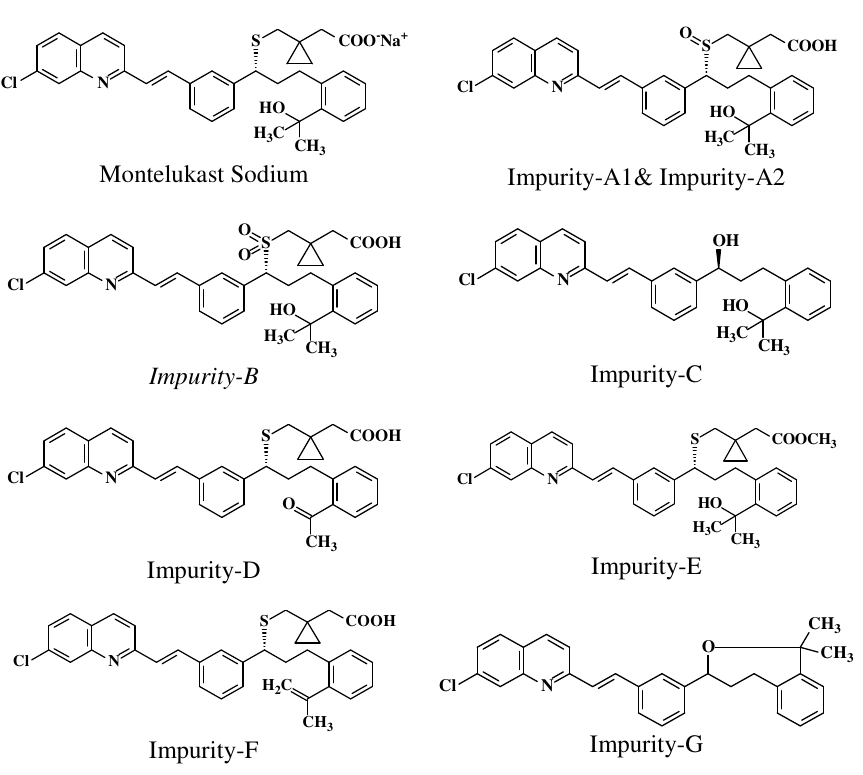
Figure 1. Chemical structures of montelukast sodium and its